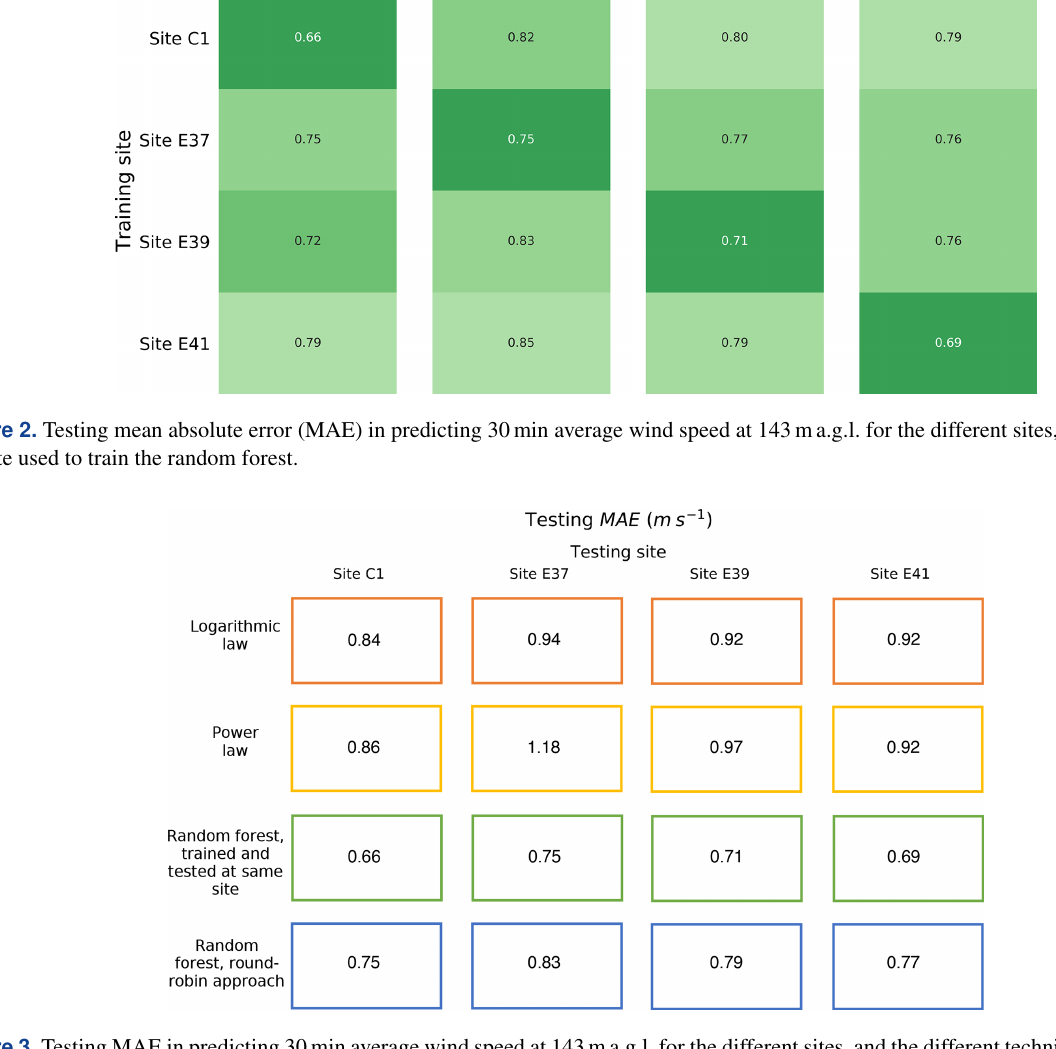
Figure 3. Testing MAE in predicting 30min average wind speed at 143ma.g.l. for the different sites, and the different techniques considered in the